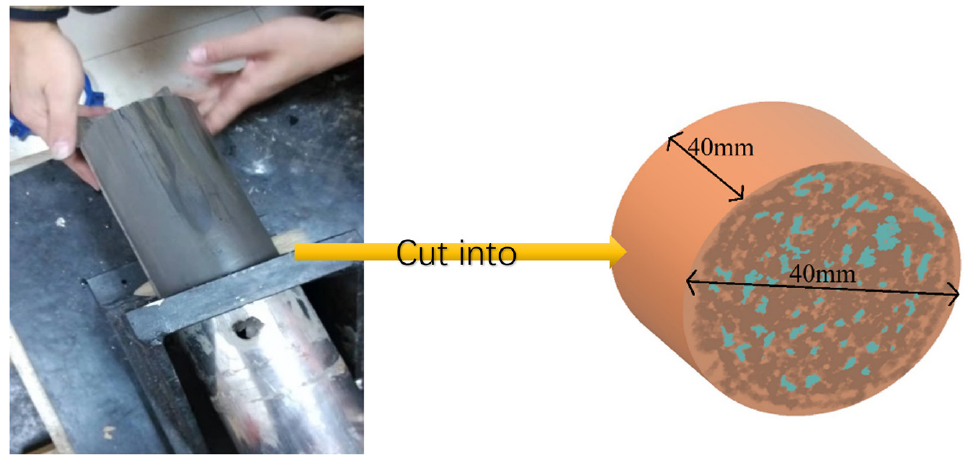
Figure 1. Photograph of undisturbed soft soil sample.